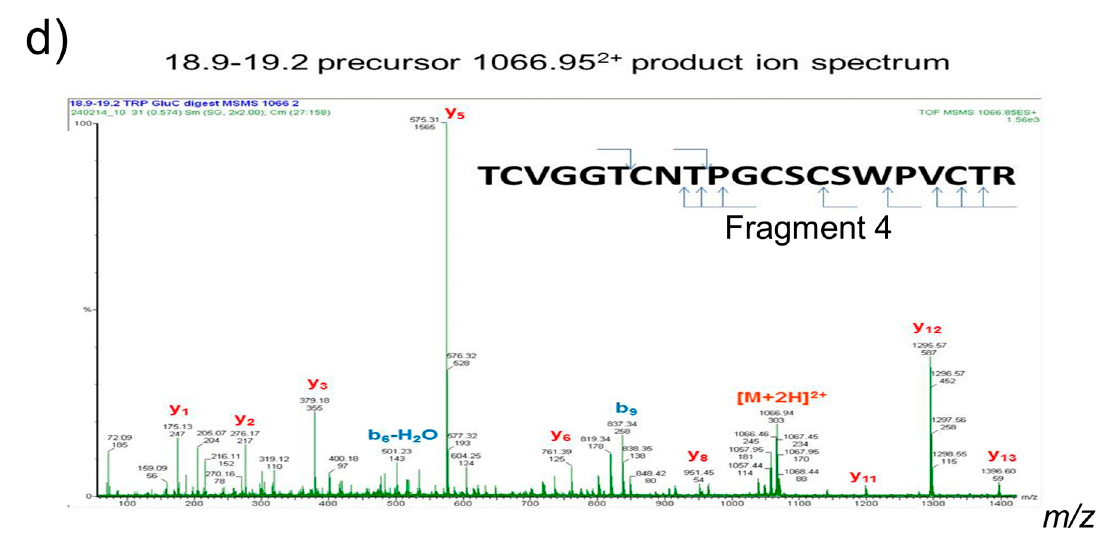
Figure 1. 3D structure, purification and identification of cyclotides. ( a ) 3D cartoon structure of kalata b1 (PDB ID:1KAL) illustrating the knotted pattern with three internal disulfide bonds (yellow and stick); ( b ) Semi-preparative HPLC showing elution of cyclotides from V. philippica , P1, P2, and P3; ( c ) A survey mass spectrum of four digested peptide fragments of Varv A; ( d ) Product ion spectrum of fragment 4 (derived from Varv A).